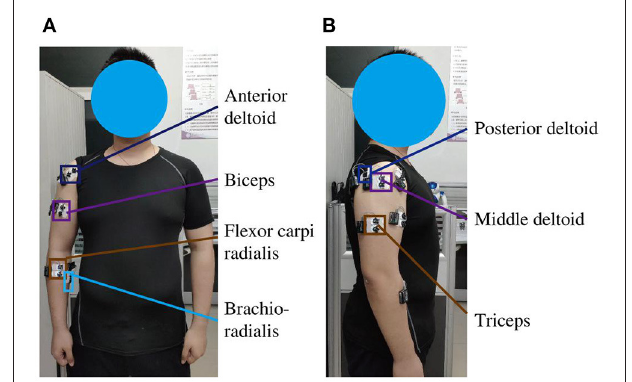
FIGURE 2 | Experimental configuration of EMG sensors with dual electrodes on the right arm of subjects. (A) Positions of sensors on the anterior deltoid, biceps, brachioradialis, and flexor carpi radialis. (B) Positions of sensors on the middle deltoid, posterior deltoid, and triceps.